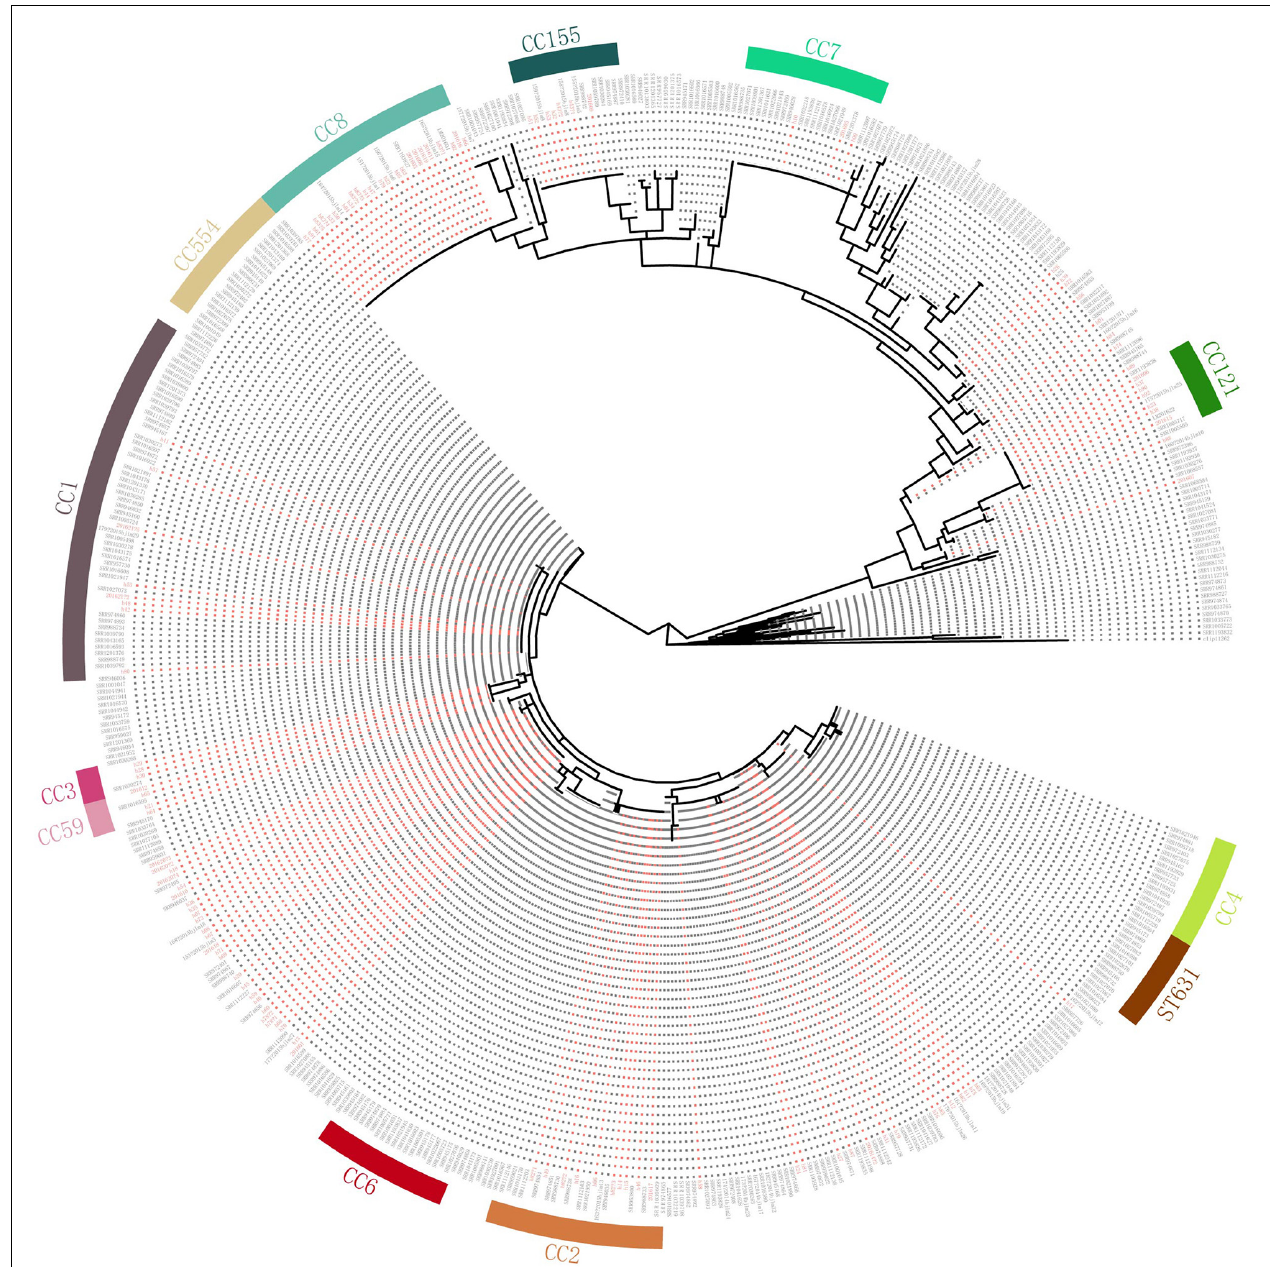
FIGURE 3 | Comparison with isolates in the United States. Clustering of 151 L. monocytogenes isolates in our study and 368 human L. monocytogenes isolates from the United States based on single-linkage analysis of the cgMLST profiles. Red color represents isolates in our